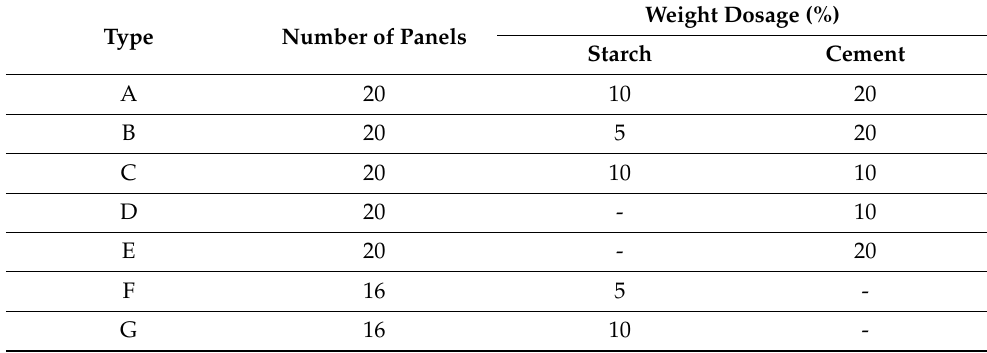
Table 1. Types of panels manufactured.